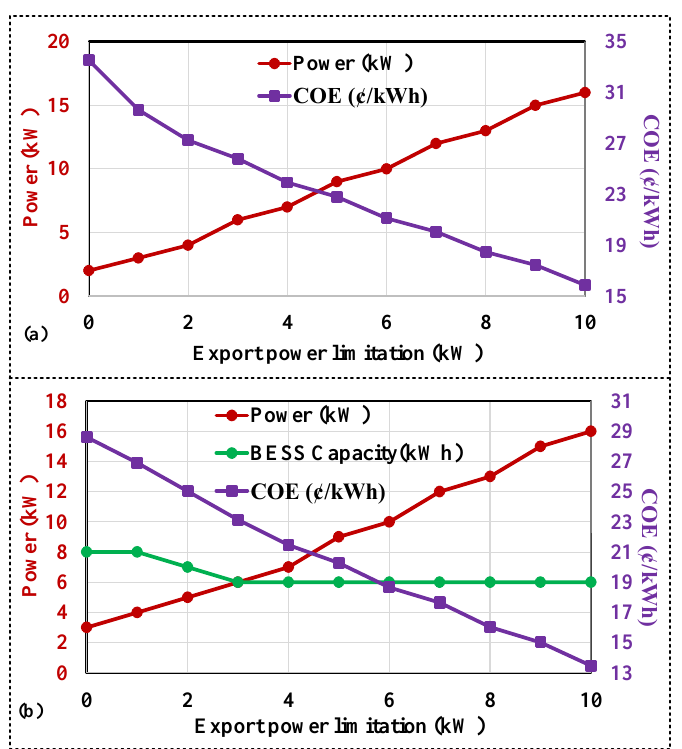
Figure 9. Sensitivity analysis for the impact of export power limitation using Option 2: ( a ) PV only; ( b ) PV-BESS.